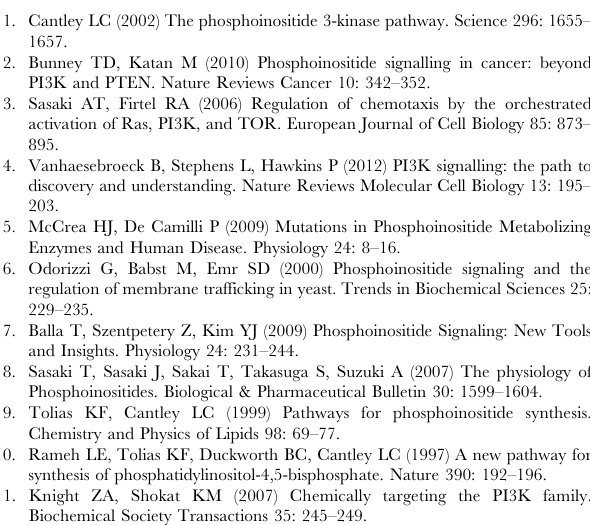
Figure S1 Assay performance comparison. Comparison of assay performance of the luciferase-coupled assay system using the lipid prepared in DMSO and the lipid prepared from lipid cakes. The luminescence from enzyme and no enzyme preparations using the lyophilized lipid cakes sonicated in buffer method (black) and the DMSO method (checkered) are shown. Standard deviation error bars are shown (N = 2). Figure S2 DMSO effect on the performance of the luciferase-coupled assay system. DMSO concentrations were tested from 5–30%. Testing below 5% DMSO was not feasible due to the requirement of DMSO for solubilization of the substrate. Standard deviation error bars are shown (N= 2). Figure S3 Assay performance on robotic system. Stable performance of the PI5P4K a assay was obtained in the 1536-well assay scale-up experiment performed on a fully-automated robotic platform [41] (147 plates tested). The Z’ factor is shown as a function of assay plate. (TIF)